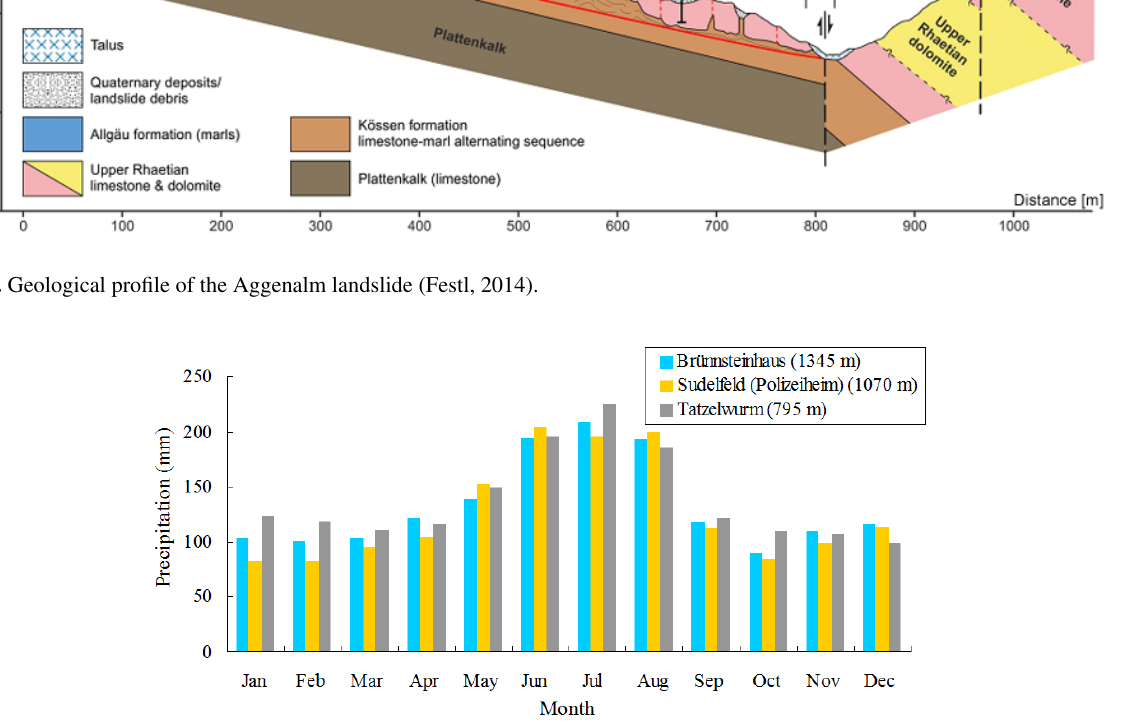
Figure 4. Mean monthly precipitation (1931–1960 and 1961–1990) for the Brünnsteinhaus, the Sudelfeld (Polizeiheim) and Tatzelwurm meteorological stations (data from Germany’s National Meteorological Service,